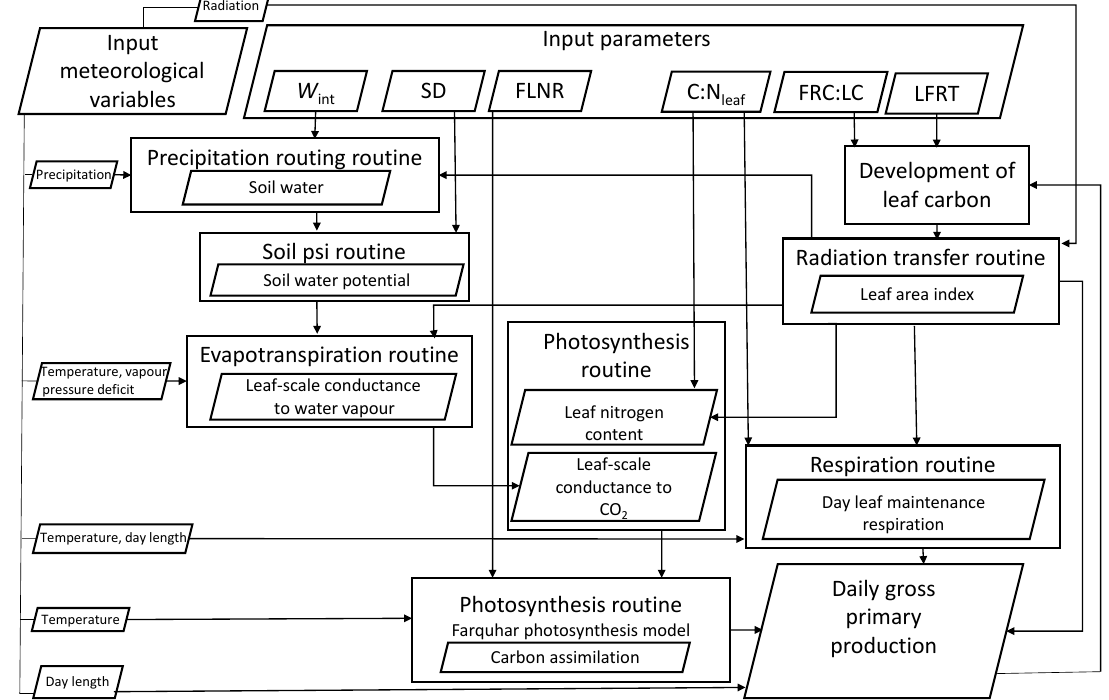
Figure 7. The Biome-BGC internal routines that simulate GPP, controlled by the meteorological data and the six calibrated parameters. Rectangular boxes represent the Biome-BGC routines and the parallelograms represent the input and output of the routine. Information about the Biome-BGC parameters is given in Table